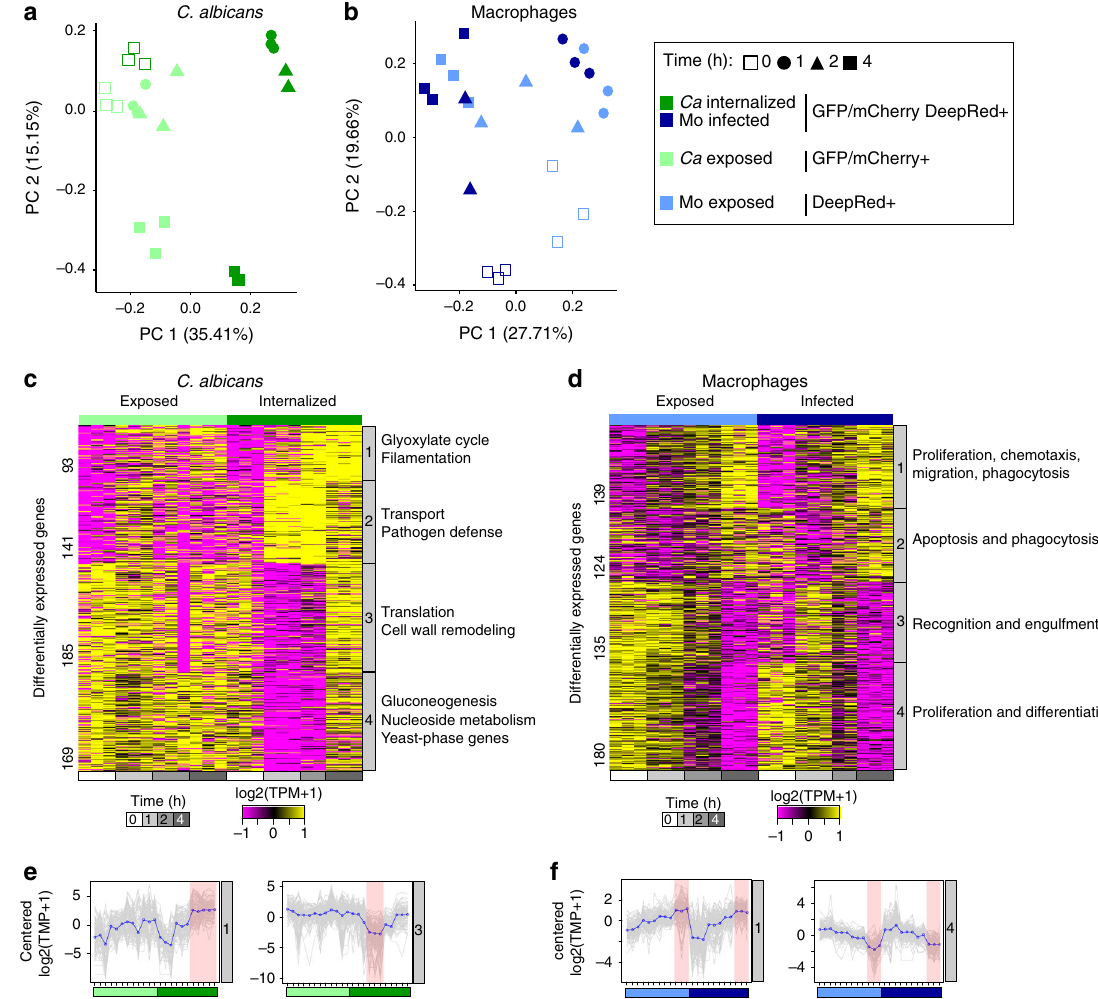
Fig. 2 Dual RNA-Seq pro fi ling revealed dynamic host – pathogen response. Principal component analysis (PCA) using the transcript abundance for the pathogen ( a ; Candida albicans ) and the host ( b ; macrophages) using signi fi cantly differentially expressed genes (DEGs; FC > 4, FDR < 0.001) in live C. albicans -phagocytized macrophages (GFP + mCherry + Deep Red + ) compared to all other conditions. Contributions of each infection outcome replicate (points) to the fi rst two principal components (PC1 and PC2) are depicted. The projection score (red: high; blue: low) for each gene (row) onto PC1 and PC2 revealed four clusters in both host and pathogen. For each projection score cluster, immune response genes (macrophages) and functional biological categories ( C. albicans ; deducted from GO-term enrichment analysis) are shown. c Transcriptional response in subpopulations of C. albicans . Heatmap depicts signi fi cantly differentially expressed genes (color scheme of gene expression level (log 2 (transcripts per million (TPM) + 1)) from − 1 (purple) to 1 (yellow)) for replicates of each C. albicans sorted populations (exposed and phagocytosed) at 0, 1, 2 and 4 h postinfection, grouped by k-means (similar expression patterns) in four clusters. Each cluster includes synthesized functional biological relationships using Gene Ontology (GO) terms (corrected P < 0.05; Fisher ’ s Exact Test). d Transcriptional response in subpopulations of macrophages. Heatmap depicts signi fi cantly differentially expressed genes (color scheme of gene expression level (log 2 (TPM + 1)) from − 1 (purple) to 1 (yellow)) for replicates of each macrophage-sorted populations (exposed and infected) at 0, 1, 2 and 4 h postinfection, clustered by k-means (similar expression patterns). Each cluster includes synthesized functional biological relationships using IPA terms ( − log( P value) > 1.3; z -score > 2; right-tailed Fisher ’ s exact test). Expression patterns for e clusters 1 and 3 in C. albicans and f cluster 1 and 4 in macrophages. The expression level for each gene is plotted (gray) in addition to the mean expression pro fi le for that cluster